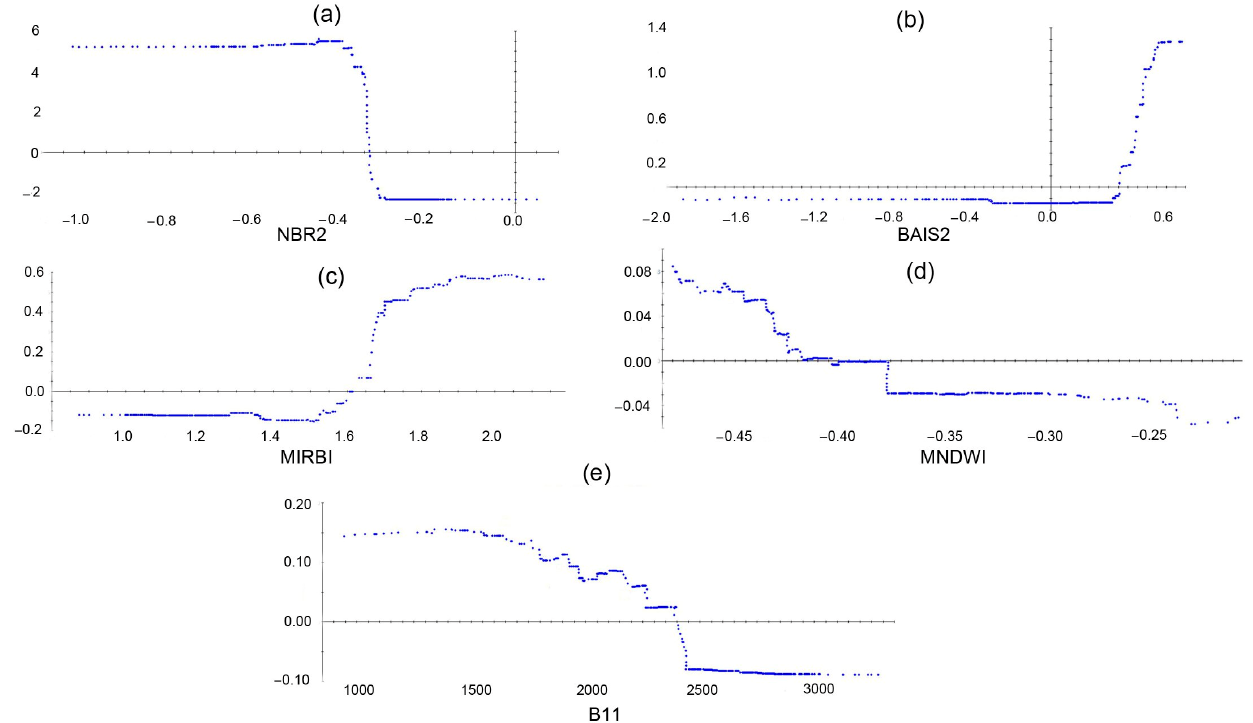
Figure 6. Univariate partial dependence plots for the top five variables derived from Sentinel-2 in enhancing burned areas, including ( a ) the Normalized Burn Ratio2 (NBR2), ( b ) the Burned Area Index for Sentinel-2 (BAIS2), ( c ) the Mid-Infrared Burn Index (MIRBI), ( d ) the Modified Normalized Difference Water Index (MNDWI), and ( e ) the shortwave infrared 1 band (SWIR1; B11).